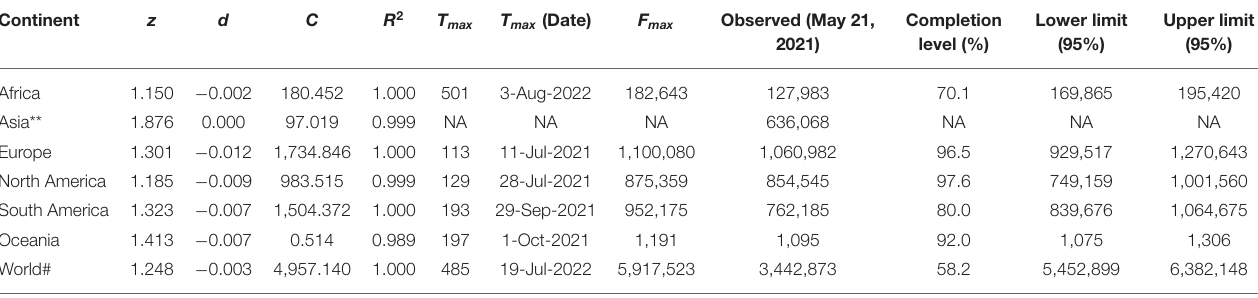
Completion Lower limit Upper limit 2021) level (%) (95%) (95%)